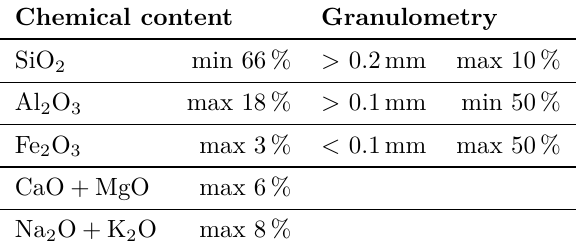
Table 1. Composition of used fine perlite.